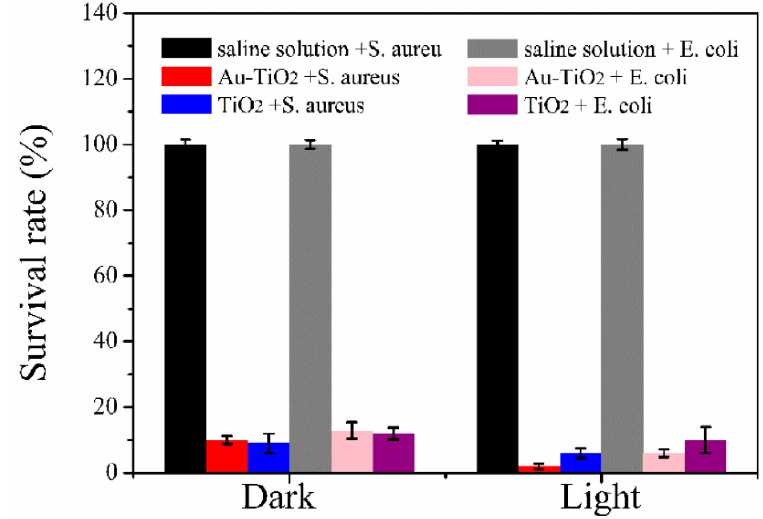
Figure 4. Antibacterial activities of saline solution, sodium alginate / TiO 2 nanocomposite (ST) film and sodium alginate / Au-TiO 2 nanocomposite (SAT) film for S. aureus and E. coli with and without visible light illumination, respectively. Reproduced with permission from ref. [82]. Copyright © 2018,